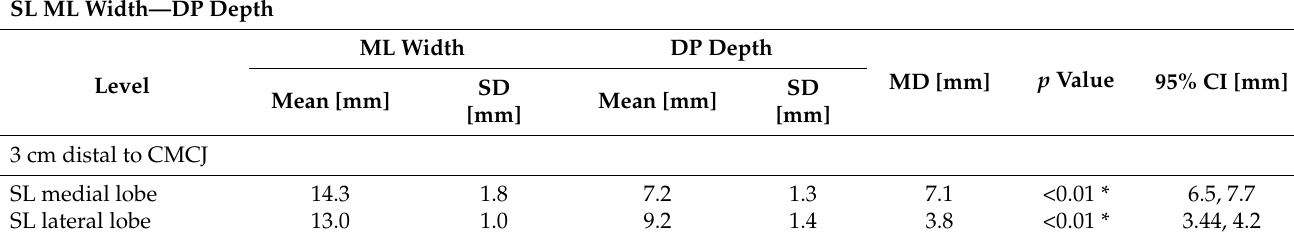
Table 4. Results of the pre-season (1st examination) and post-season (2nd examination) pooled data analysis for 12 endurance horses examined at an interval of approximately six months, using the paired samples t -test or the Wilcoxon signed-rank test for the comparison of the mediolateral (ML) width and dorsopalmar depth (DP) of the suspensory ligament (SL) and its lobFes (top) and medial and lateral lobes of the SL, at 2, 3, 5, and 7 cm distal to the carpometacarpal joint (CMCJ); NNDD—not normally distributed data; SD—standard deviation; MD—mean difference; CI—confidence intervals. * = statistically significant, p <